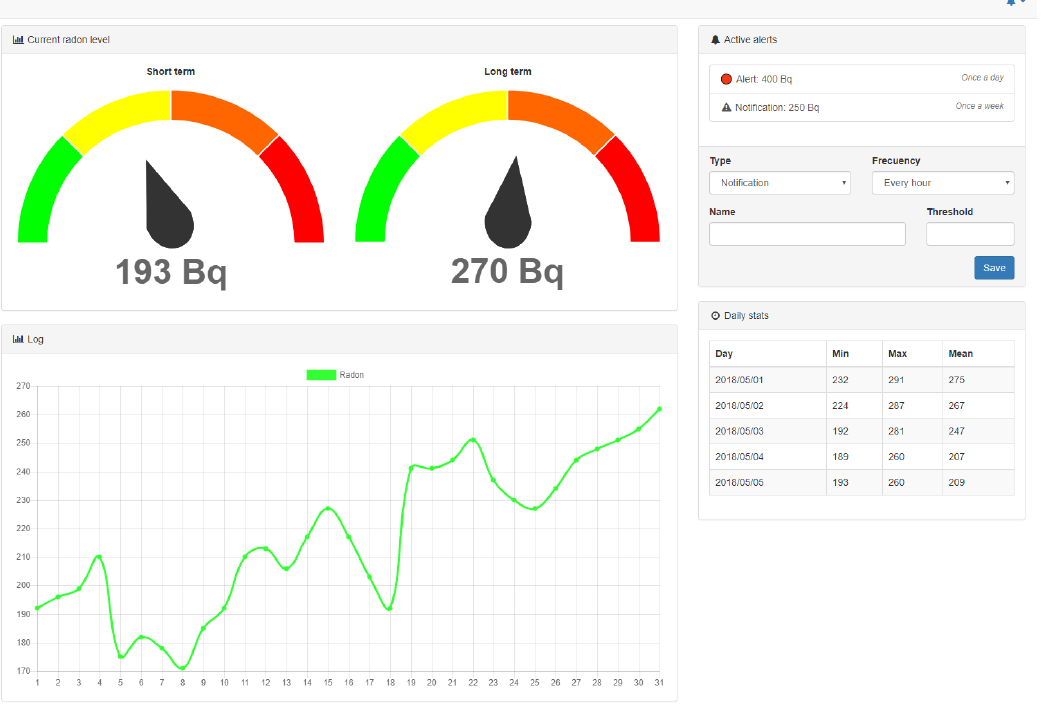
Figure 7. Dashboard of the radon gas monitoring